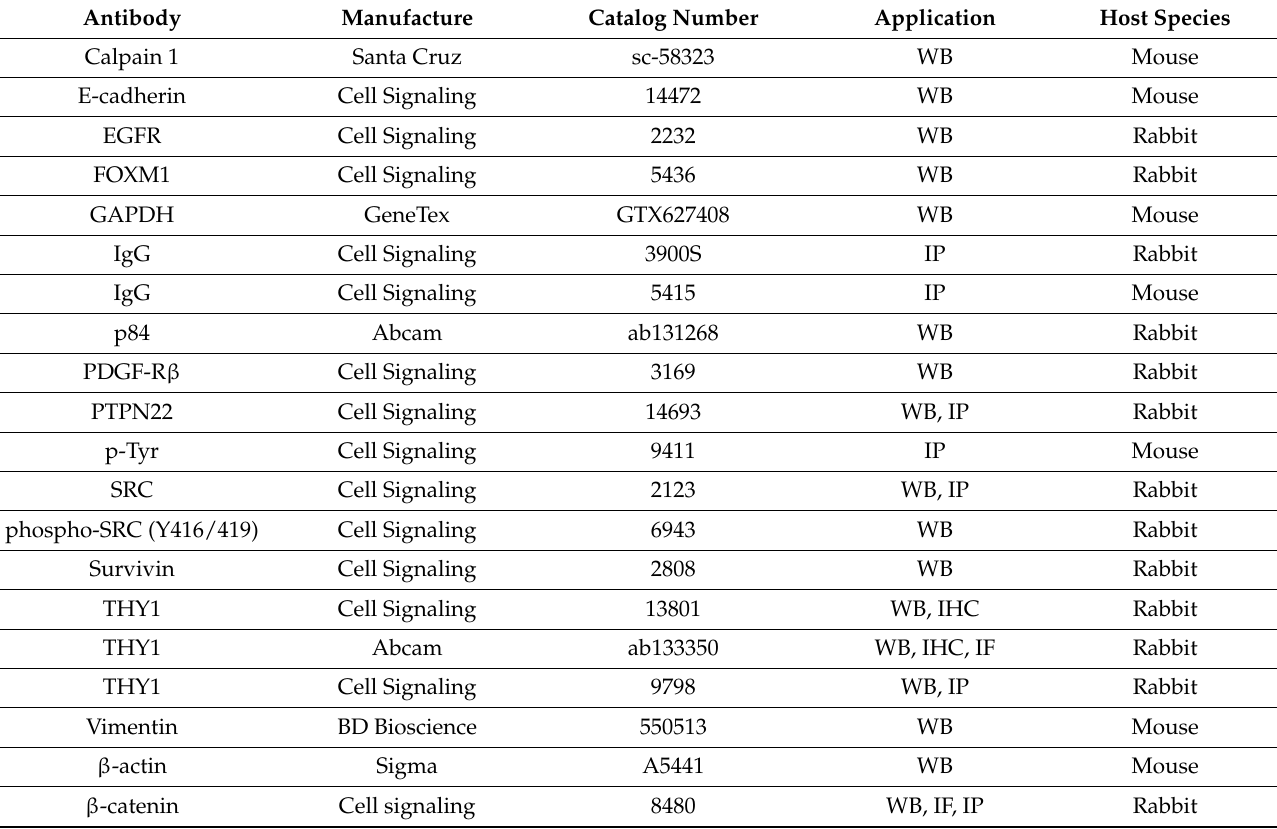
Table 1. List of antibodies used in this